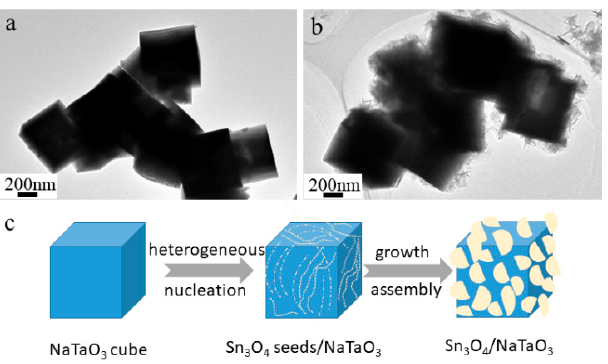
Figure 3. TEM images of NaTaO 3 ( a ), Sn/NTO ( b ), and a schematic diagram of the growth process of Sn/NTO ( c ).